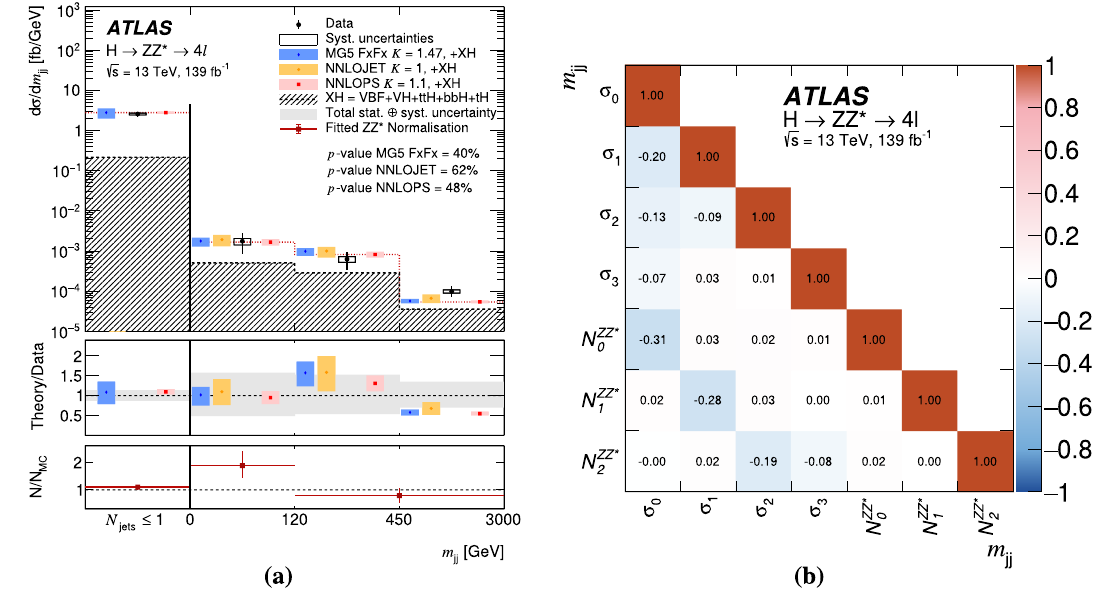
Fig. 27 Differential fiducial cross sections for a the invariant mass of the two highest- p T jets, m jj , in events with at least two jets. The corresponding correlation matrix between the measured cross sections and the Z Z ∗ background normalisation factors is also provided ( b